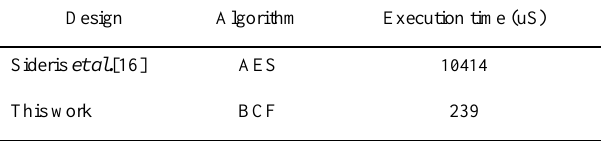
Table 13. Comparasion of Block Cipher 128-bit implementation on FPGA